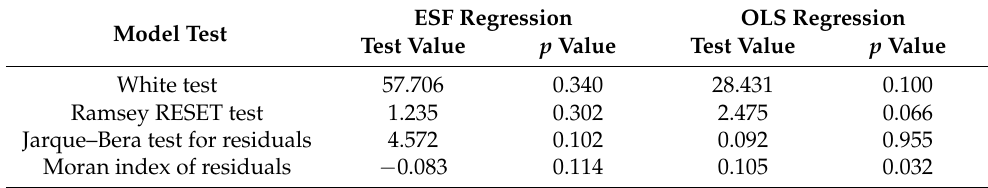
Table 8. Model test of OLS regression and ESF regression (ln(Econ_V) as the dependent